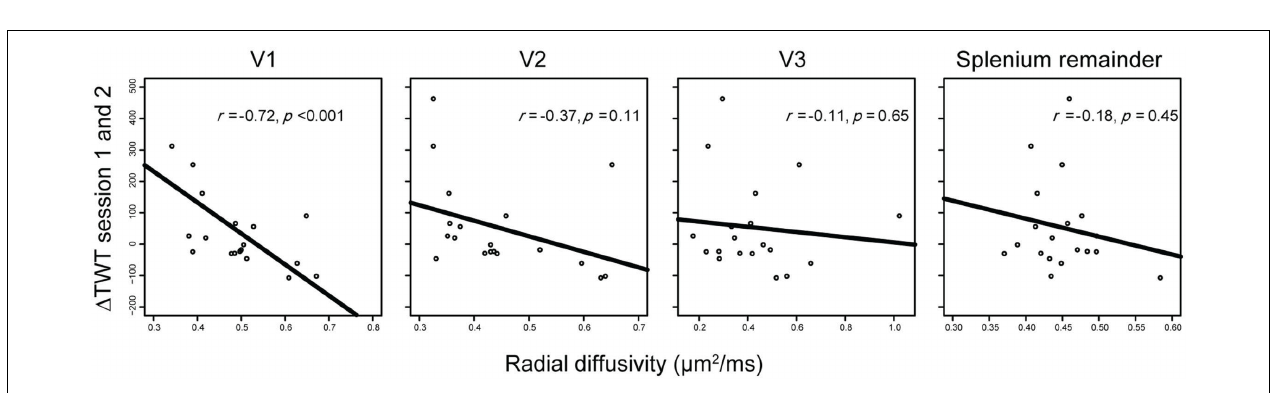
FIGURE 5 | Correlations between interhemispheric delays and fiber properties of different callosal projections. Only radial diffusivity (RD) ofV1 callosal projections predicted behavioral variance in Δ TWT; no reliable relationships were found between Δ TWT and RD in callosal projections ofV2,V3, or the splenium